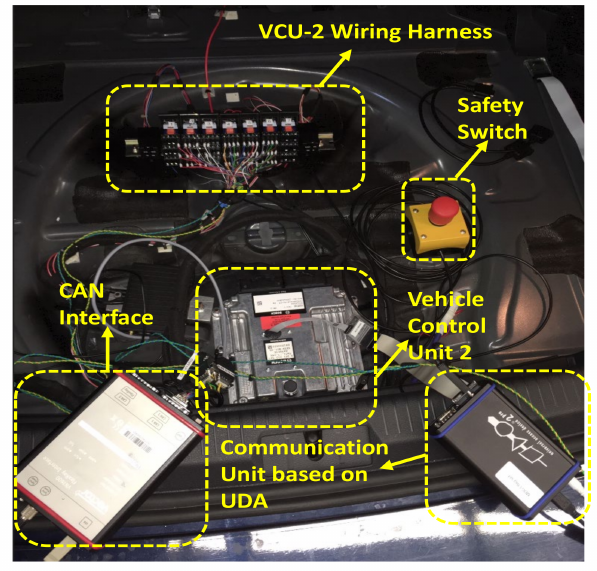
Figure 4. Additional VCU installation with necessary wiring and communication